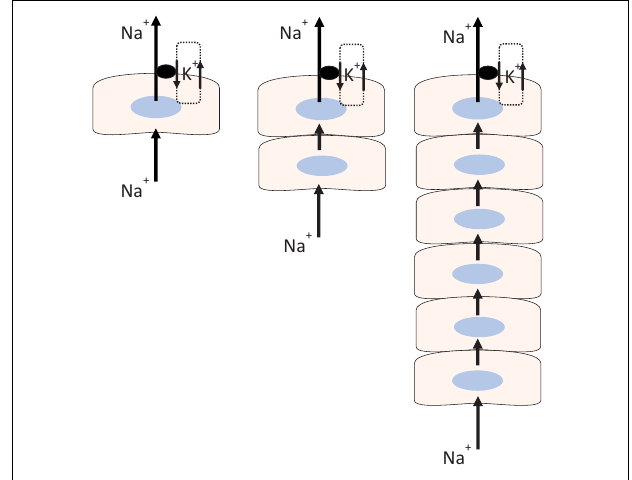
FIGURE 1 | Sodium-potassium homeostasis in a single cell (Left), is made possible because Na, K-ATPase activity increases or decreases in response to changes in cytoplasmic sodium concentration at the sodium ion binding site. The model shows an arrangement in which the cell with Na, K-ATPase activity is required to maintain steady state sodium and potassium concentrations in two (Center) or more coupled cells (Right) that have little or no Na, K-ATPase activity. The model depicts sodium ions flowing through the coupled cells to be actively transported outward by Na, K-ATPase while potassium channels recirculate potassium ions the Na, K-ATPase brings into the